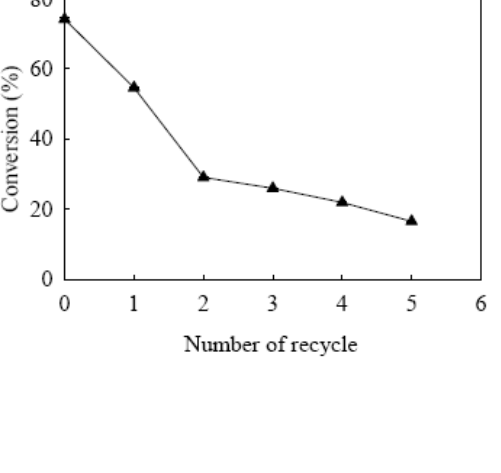
Figure 5. Reusability of Pseudomonas cepacia lipase entrapped in biomimetic silica. The transesterification of soybean oil was carried out at 43.6 °C, substrate molar ratio of 4.3 (stepwise additions at 0, 12 and 24 h, one third of the total amount each time), and 75% (w/w of oil) n -hexane; the dosage for entrapped lipase was 50 mg and the reaction mixture also contained 960 μ L of deionized